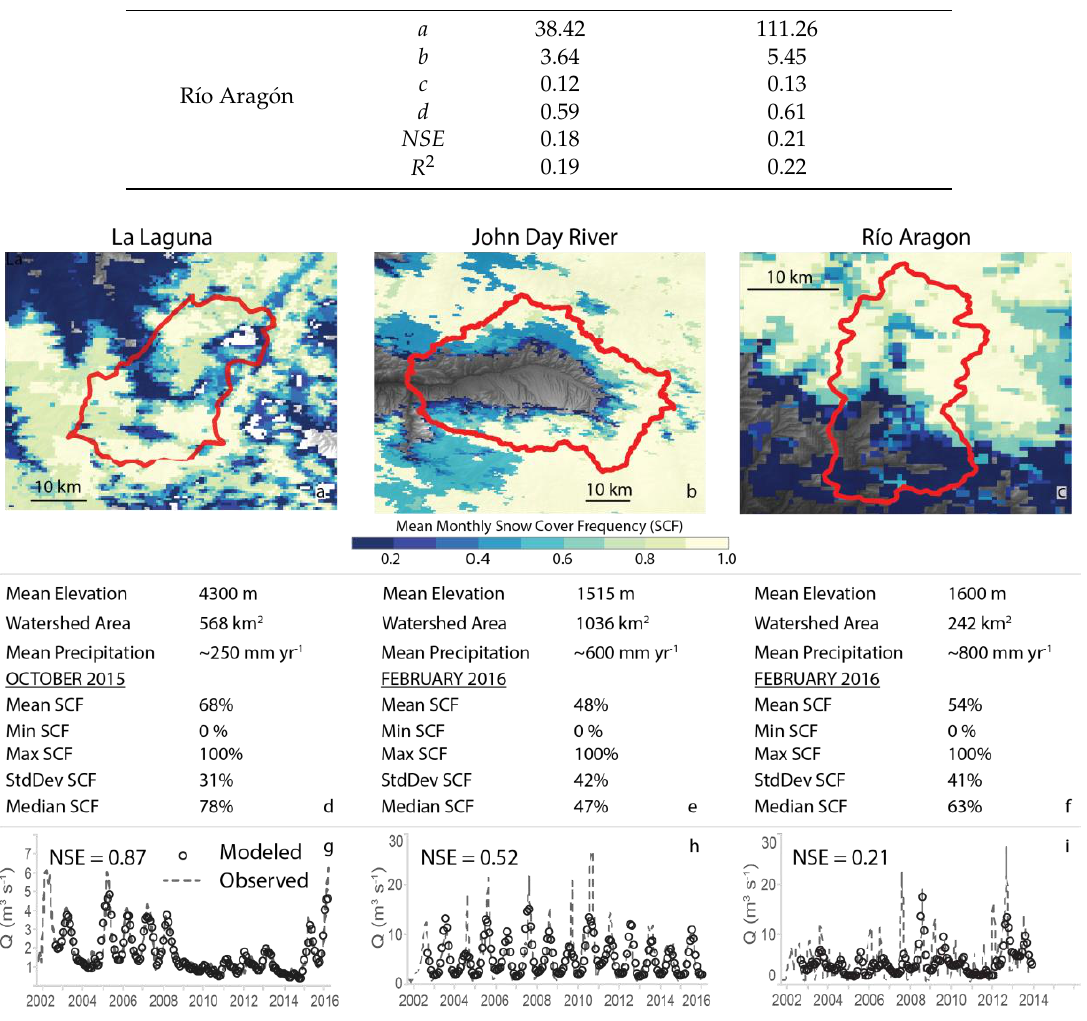
Figure 3. ( a – c ) Maps of monthly SCF calculated in SnowCloudMetrics for the three watersheds. ( d – f ) Topographic, climatic, and SCF metrics for the three watersheds. ( g – i ) The SnowCloudHydro results for the three watersheds. NSE refers to the Nash-Sutcliffe Efficiency coefficient, a standard metric applied to assess the predictive skill of hydrologic models [38,39].